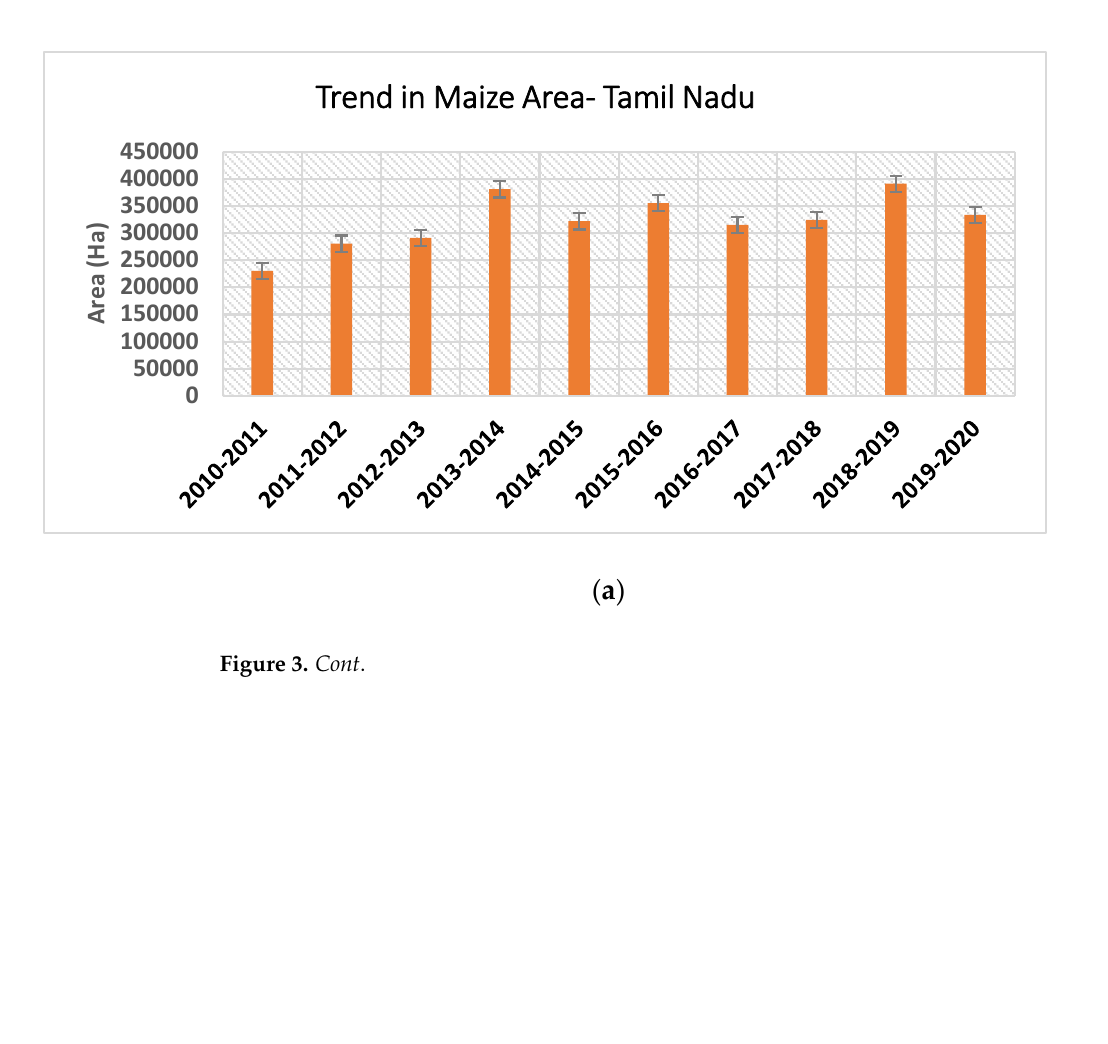
Figure 2. Maize production statistics in India from 1971 to 2020. (Source: DoES,TN).